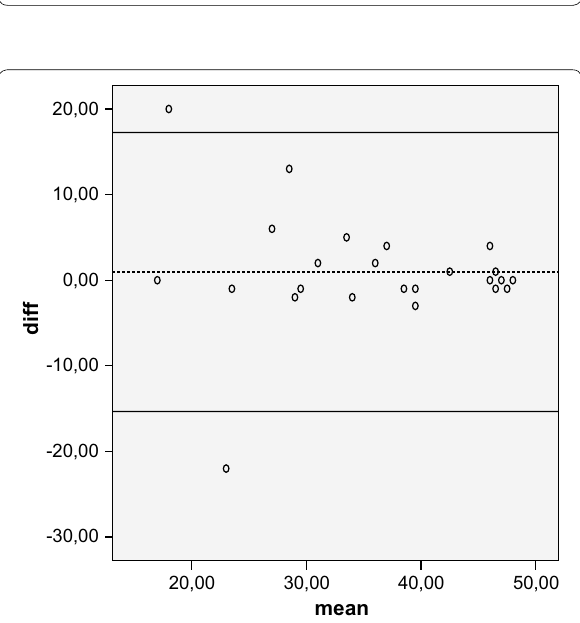
Fig. 3 Bland–Altman plot showing test–retest results for 33 patients completing the Italian version of the Lysholm index. The dashed line shows the mean difference; solid lines show the 95 % confidence interval